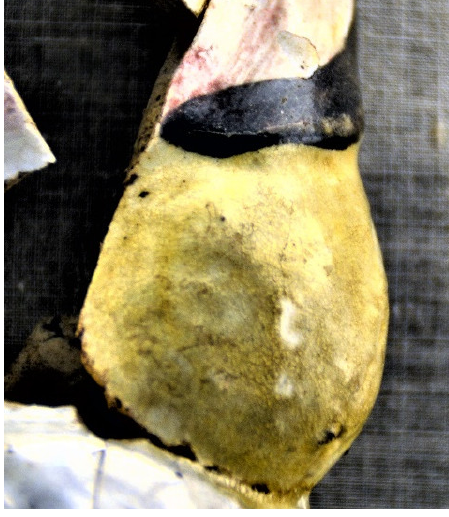
Figure 12. Polychrome figurine from Anan’evka walled settlement. Yellow glaze is on the surface of the bag-shaped convexity.